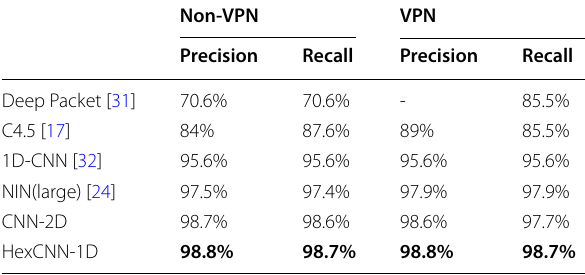
Table 5 Comparison with experimental results of different